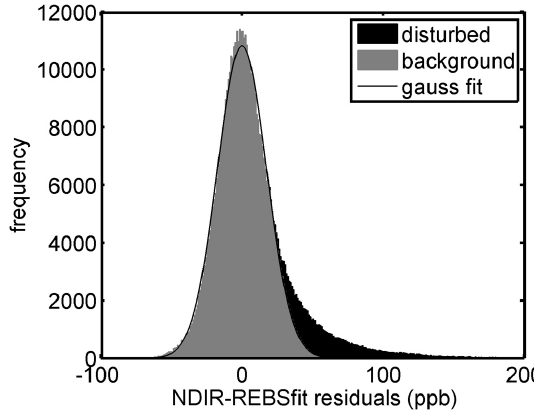
Fig. 2. Histograms of filtered (grey) and rejected (black) NDIR- REBS residuals data using REBS